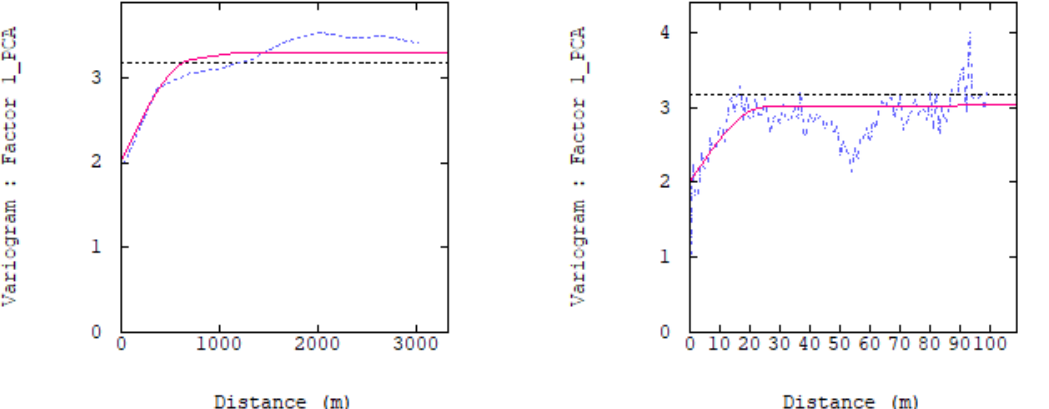
Figure 12. Experimental and fitted anisotropic variogram models for Factor 1. Dashed polylines (blue color) represent experimental variograms; thin dashed lines (black color) represent variance; continuous lines (red color) represent variogram models.